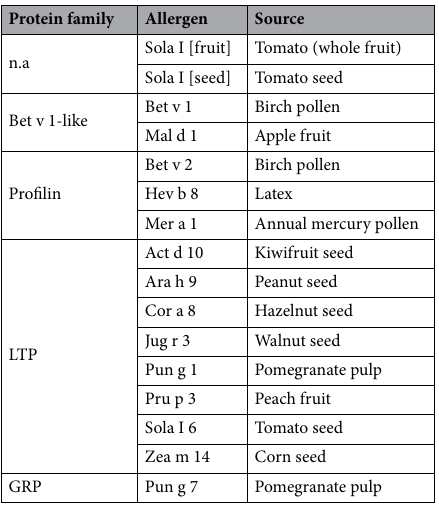
Table 6. Details of allergens immobilized on the FABER biochip and probed with the tomato extracts using the SPHIAa test.